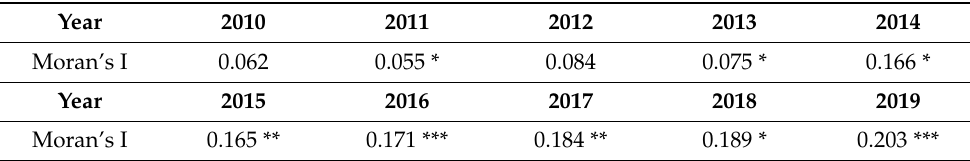
Table 7. Moran’s I index for resource-based